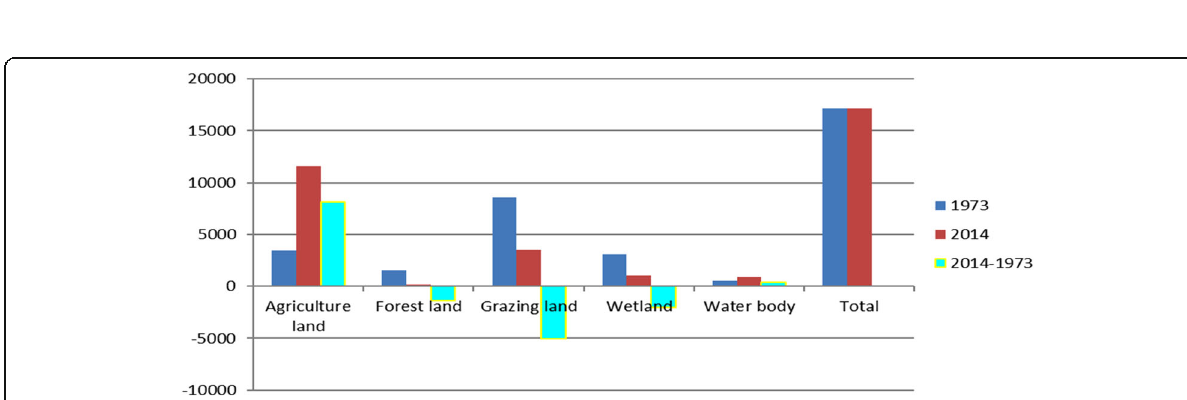
Fig. 8 Land use/land cover change of the study site map in the year 1973 and 2014